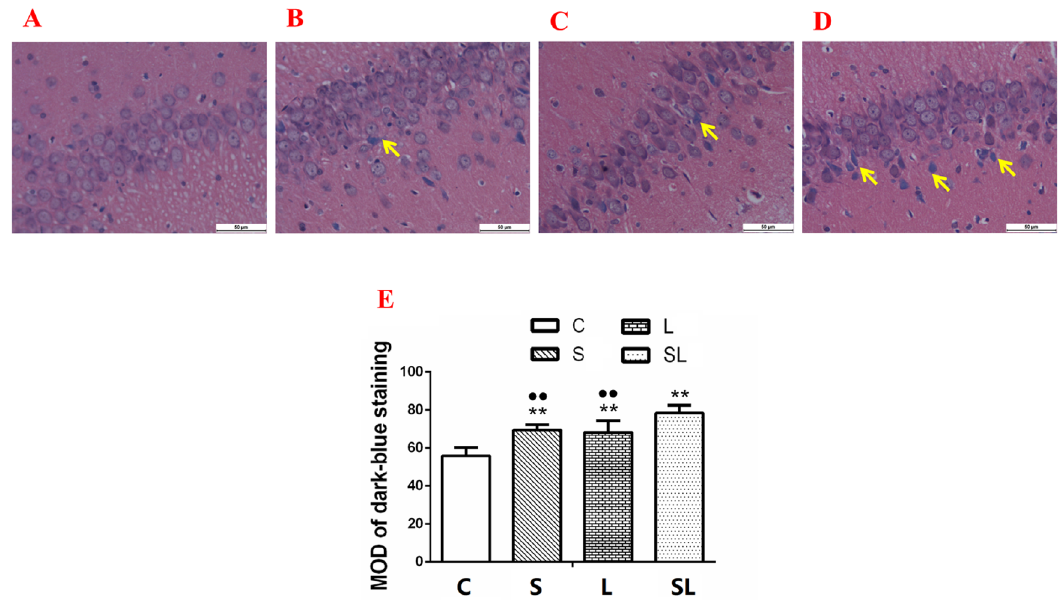
Figure 3. Pathological injuries in the hippocampus of rats 6 h after 2.856 GHz and 1.5 GHz microwave exposure. The microstructures were detected by LM 6 h after exposure to support the behavioral results. ( A – D ) Hippocampi of the C group, S group, L group and SL group. (E) Statistical analysis results of the MOD of dark blue staining in hippocampi. Compared to the C group, ** p < 0.01. Compared to the cumulative group, •• p < 0.01. There was no neuron degeneration detected by A and E., and injuries that included karyopyknosis, an irregular arrangement of cells, cell edema, and a broadening pericellular space were found in ( B – D ). Most injuries occurred in ( D ). (H&E, scale bar = 50 μm). “C” stands for the control group, “S” stands for the 2.856 GHz microwave exposure group, “L” stands for the 1.5 GHz microwave exposure group, and “SL” stands for the 2.856 and 1.5 GHz cumulative exposure group. The data are presented as the means ±